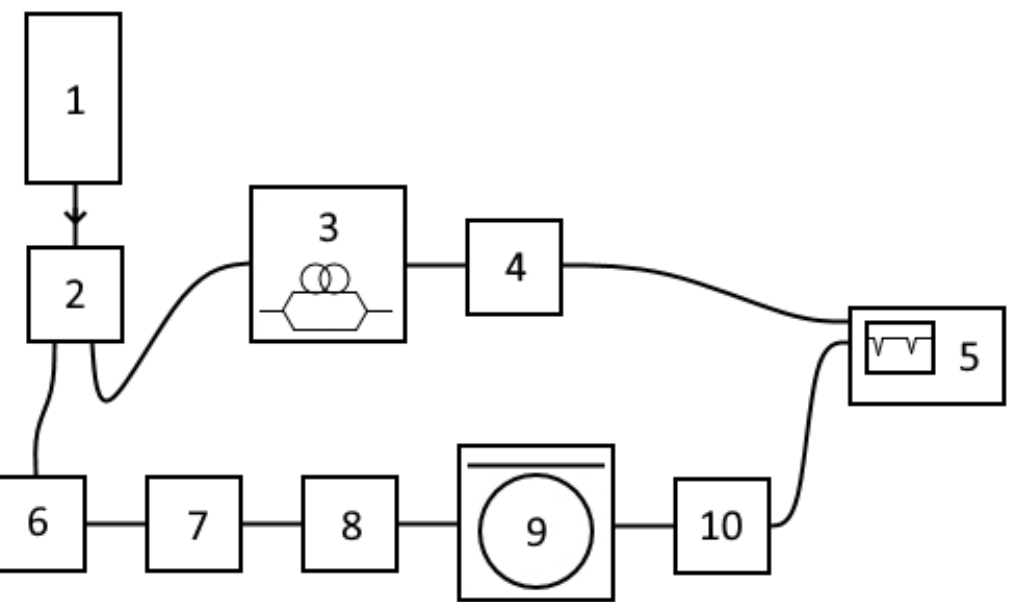
Figure 3. Scheme of the installation for studying the characteristics of fiber-optic ring resonators.